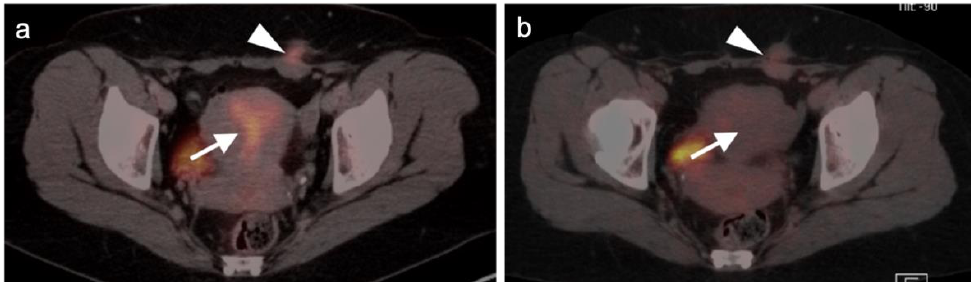
Figure 1. Physiologic hypermetabolism in the endometrium and in a scar endometrioma in a woman who underwent a prior Caesarian-section. FDG-PET-CT images of the pelvis. ( a ) Normal endometrial hypermetabolism (white arrow) occurs during the first 4 days of the menstrual cycle and during mid-cycle. An endometrial implant on the anterior abdominal wall also shows similar physiologic uptake; ( b ) A second FDG PET-CT scan performed off-cycle shows resolution of the metabolic activity both in the endometrium and in the scar endometrioma (subsequently biopsy proven).